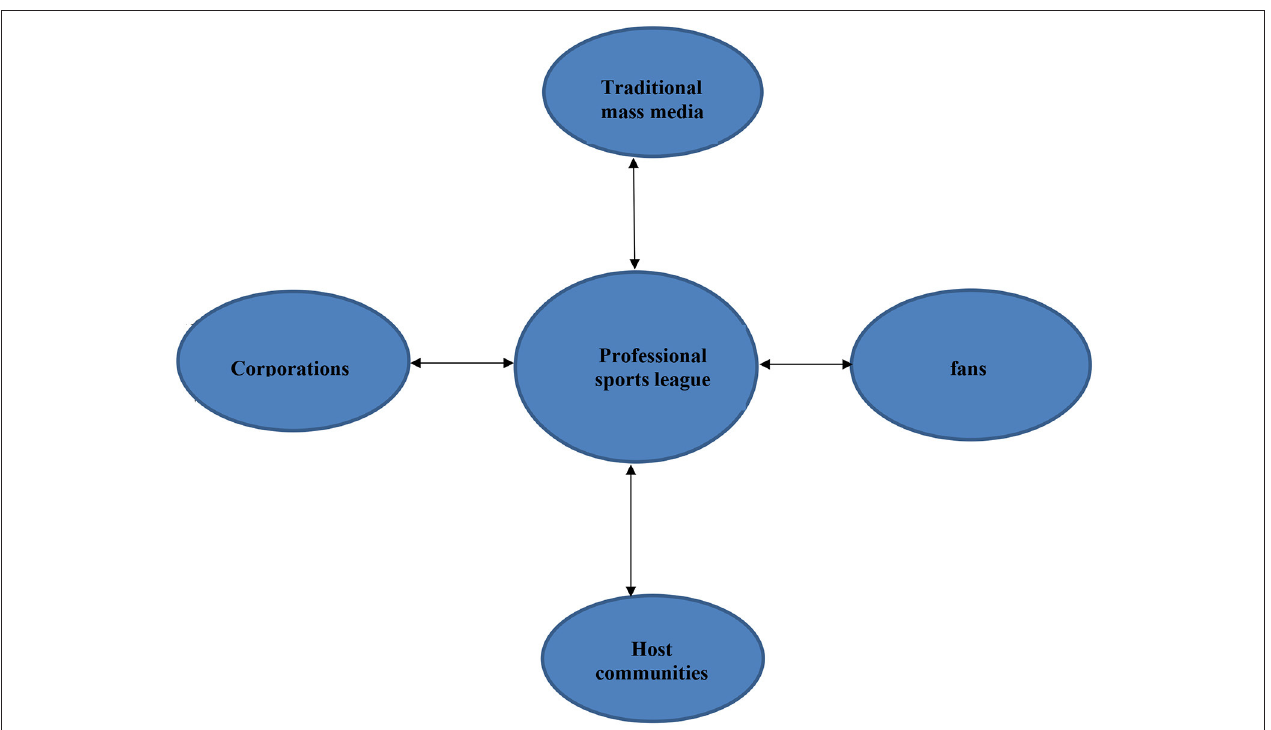
FIGURE 1 | Basic model of professional sport multi-sided market with traditional mass media (adapted from Benner and Tushman,